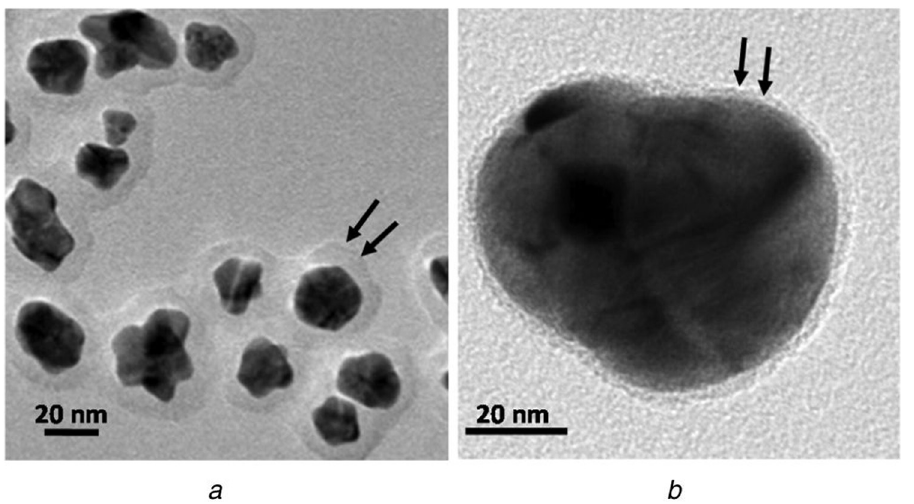
Figure 14: TEM micrographs of ( a ) phenolic acid - coated gold nanoparticles [ 190 ] and ( b ) silver/selenium alloy nanoparticles [ 191 ] .